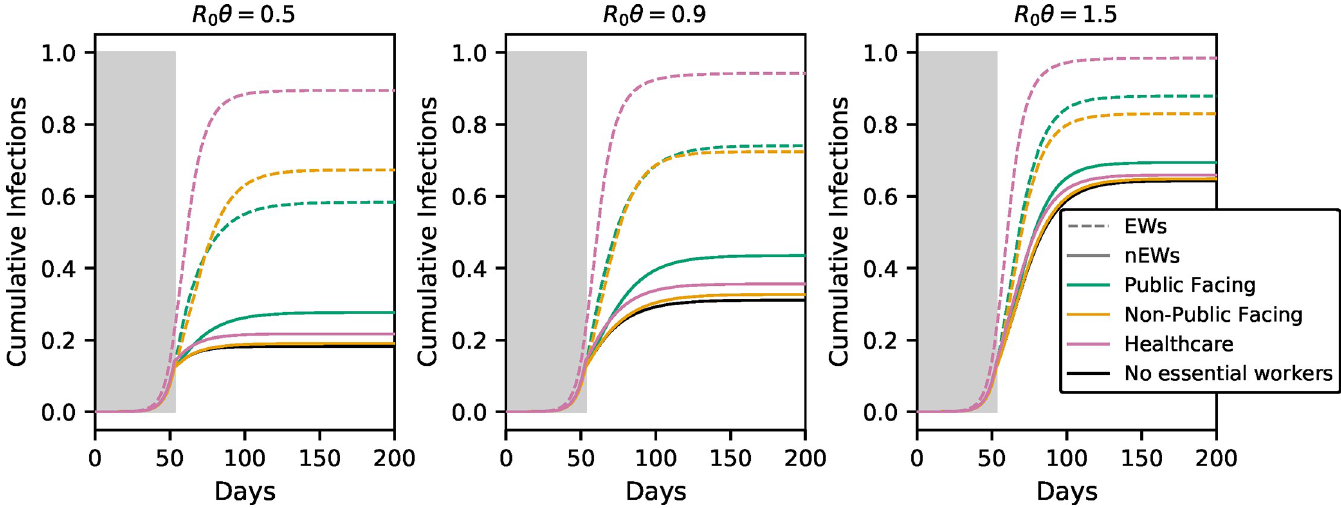
Fig 2. Cumulative infection rates among EWs and nEWs for different scenarios and values of θ . The dashed and solid lines correspond to EWs and nEWs respectively. Note that the ordering of the colors is not the same for EWs and nEWs. The proportion of EWs, f , is assumed to be 0.05 for all models. Alternative values of f yield similar qualitative results, as do alternative values of other parameters (see Section 2 and Figs 1–16 in S1 Appendix).